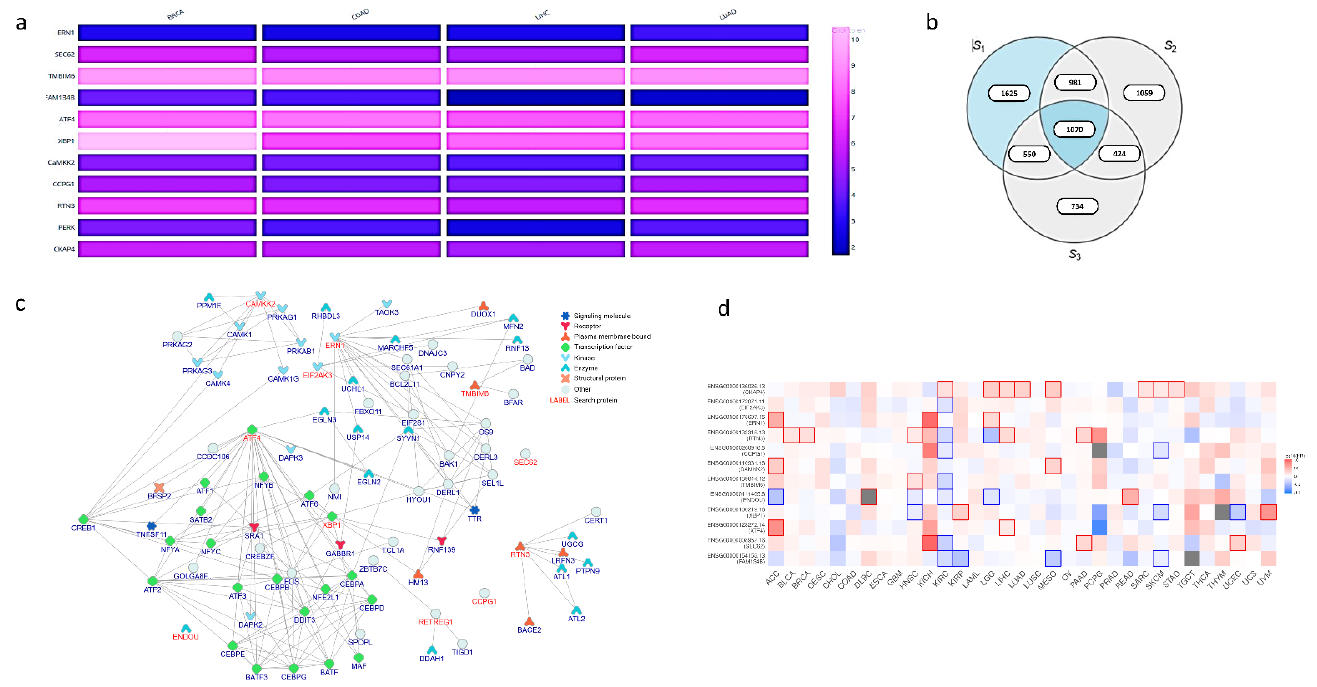
Figure 4. Current understanding of molecular components linked to ER stress and autophagy that influence tumor cell survival and their clinical relevance. ( a ) Expression profiles of ER stress proteins, ERphagy proteins, and Ca 2+ signaling proteins in TCGA cancer data (by GEPIA2). ( b ) Venn diagram of ER stress proteins, ER-phagy proteins, and Ca 2+ signaling proteins in TCGA cancer data (by NIH GDC data portal). ( c ) Protein–protein interaction data of ER stress proteins, ER-phagy proteins, and Ca 2+ signaling proteins (inBio Discover). ( d ) Survival map of ER stress proteins, ER-phagy proteins, and Ca 2+ signaling proteins associated with different TCGA cancer (GEPIA2).